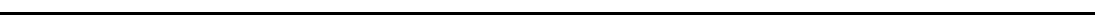
Fig. 7 Axonemal deglutamylation suppresses Hedgehog signaling. a The experimental procedure for STRIP and Hedgehog induction. Washout of rapamycin after 30 min of STRIP operation did not affect protein dimerization in cells owing to the irreversible nature of the CID system. b Axonemal deglutamylation reduces the level of Smoothened (Smo) in cilia after treatment with SAG. NIH3T3 cells were transfected with P2A-based constructs for co-expression of Cerulean3 – FRB – MAP4m and Neon-FKBP-tagged proteins. Transfected cells at 80 – 90% con fl uency were serum-starved for 24 h and then incubated with 100 nM rapamycin or 0.1% DMSO for 30 min and subsequently treated with 1 μ M SAG for 2 h. Scale bar, 5 μ m. c Smoothened in cilia was quanti fi ed after the indicated treatments ( n ≥ 18 cells from three independent experiments). d Axonemal deglutamylation reduces the level of Gli3 at the ciliary tip after treatment with SAG. NIH3T3 cells were transfected with P2A-based constructs for co-expression of Cerulean3 – FRB – MAP4m and Neon- FKBP-tagged proteins. Transfected cells at 80 – 90% con fl uency were serum-starved for 24 h and then incubated with 100 nM rapamycin or 0.1% DMSO for 30 min and subsequently treated with 1 μ M SAG for 2 h. Scale bar, 3 μ m. e Gli3 at the ciliary tip was quanti fi ed after the indicated treatments. Data represent the mean ± s.e.m. ( n ≥ 21 cells from three independent experiments). f Axonemal deglutamylation inhibits Gli activation upon Hedgehog stimulation. NIH3T3:8xGBS – GFP cells were transfected with P2A-based constructs for co-expression of mCherry – FRB – MAP4m and Cerulean3 (Ce3) – FKBP-tagged proteins. Transfected cells at 80 – 90% con fl uency were serum-starved for 24 h and then incubated with 100 nM rapamycin or